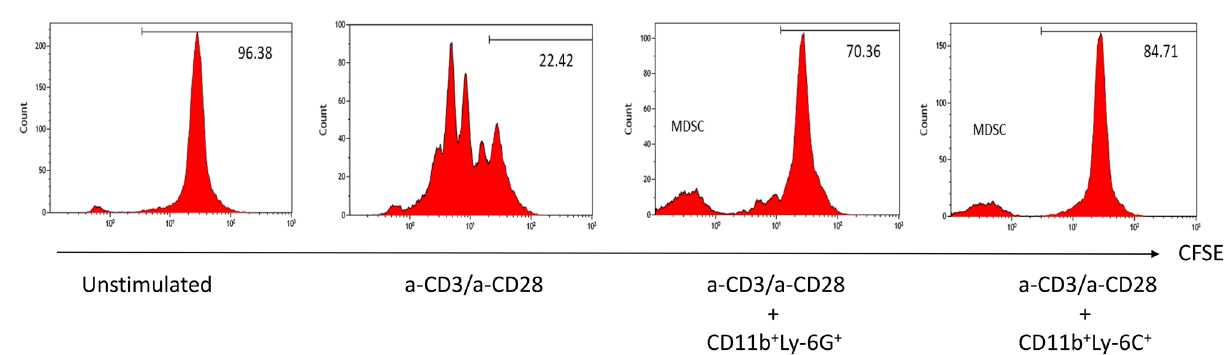
Figure 5. T-cell proliferation is suppressed by MDSCs. B10 T-cells were stained by carboxyfluorescein succinimidyl ester and activated by anti-CD3/anti-CD28. The proliferation of T-cells was suppressed by MDSC at 1:1 of T-cells and CD11b + Ly-6G + or CD11b + Ly-6C +